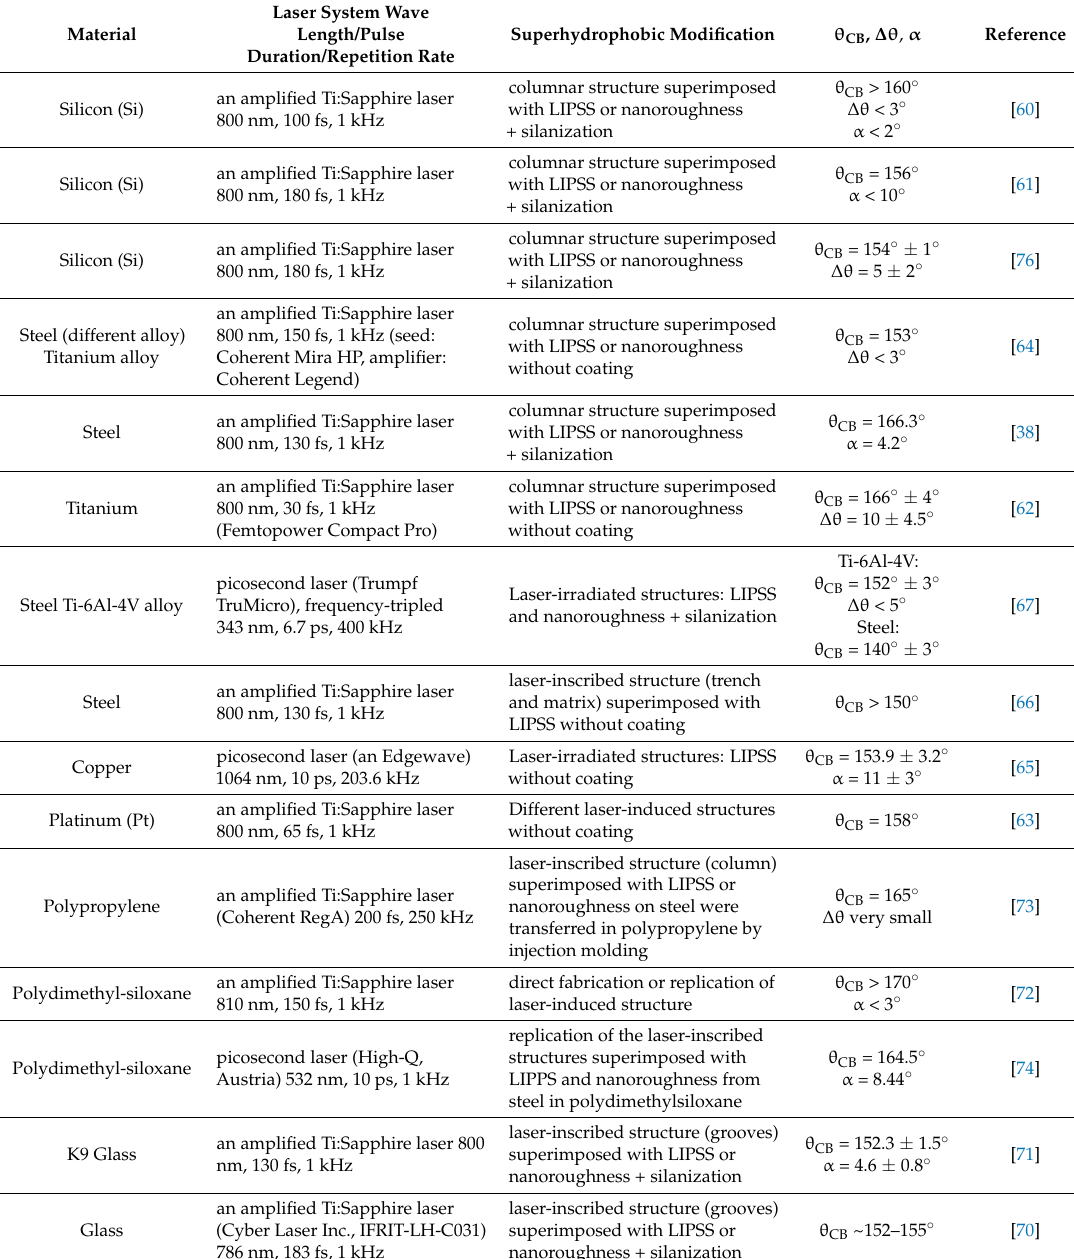
Table 2. Overview of superhydrophobic modification of different materials by ultrafast laser